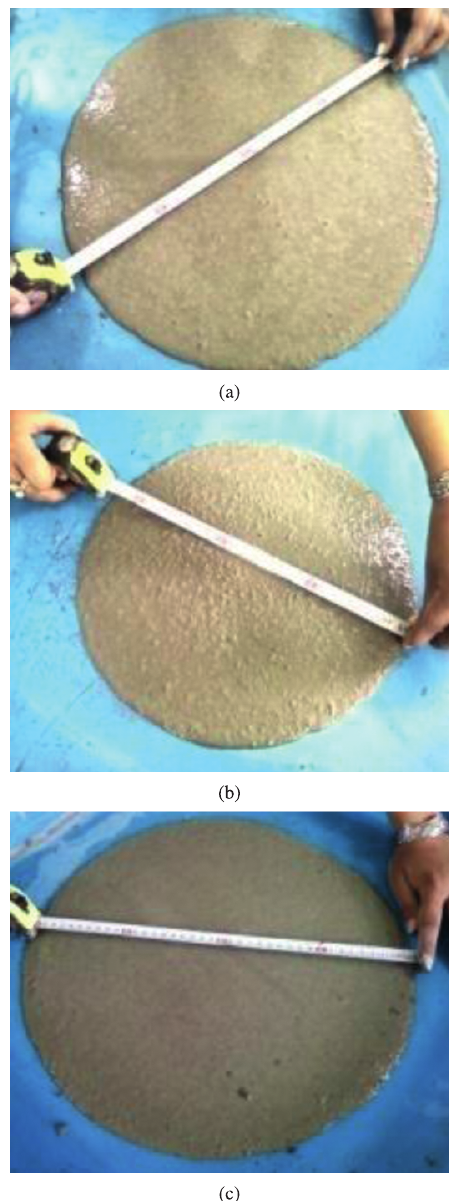
Figure 6. The bending Strength evolution of the SCMs mortars respectively with and without heat treatment as a function